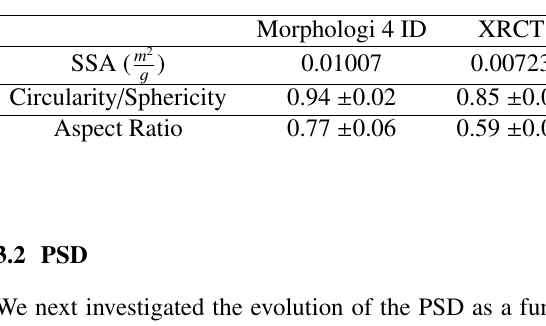
Table 2. Comparison between 2D particle projections and 3D particle shape